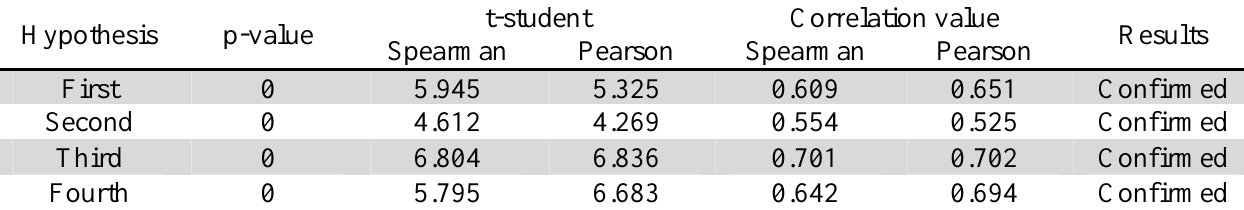
The summary of the results of Spearman and Pearson correlation tests